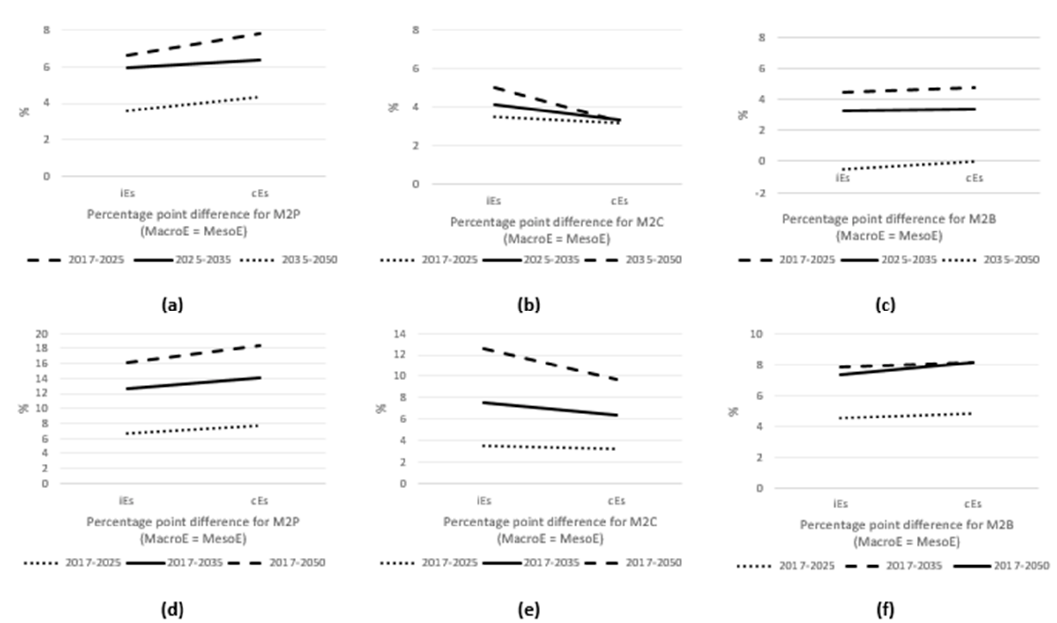
Figure 9. Percentage point differences between the M2 scenarios. ( a ) percentage point difference for M2P; ( b ) percentage point difference for M2C; ( c ) percentage point difference for M2B; ( d ) percentage point difference for M2P with respect to 2017; ( e ) percentage point difference for M2C with respect to 2017; ( f ) percentage point difference for M2B with respect to 2017.